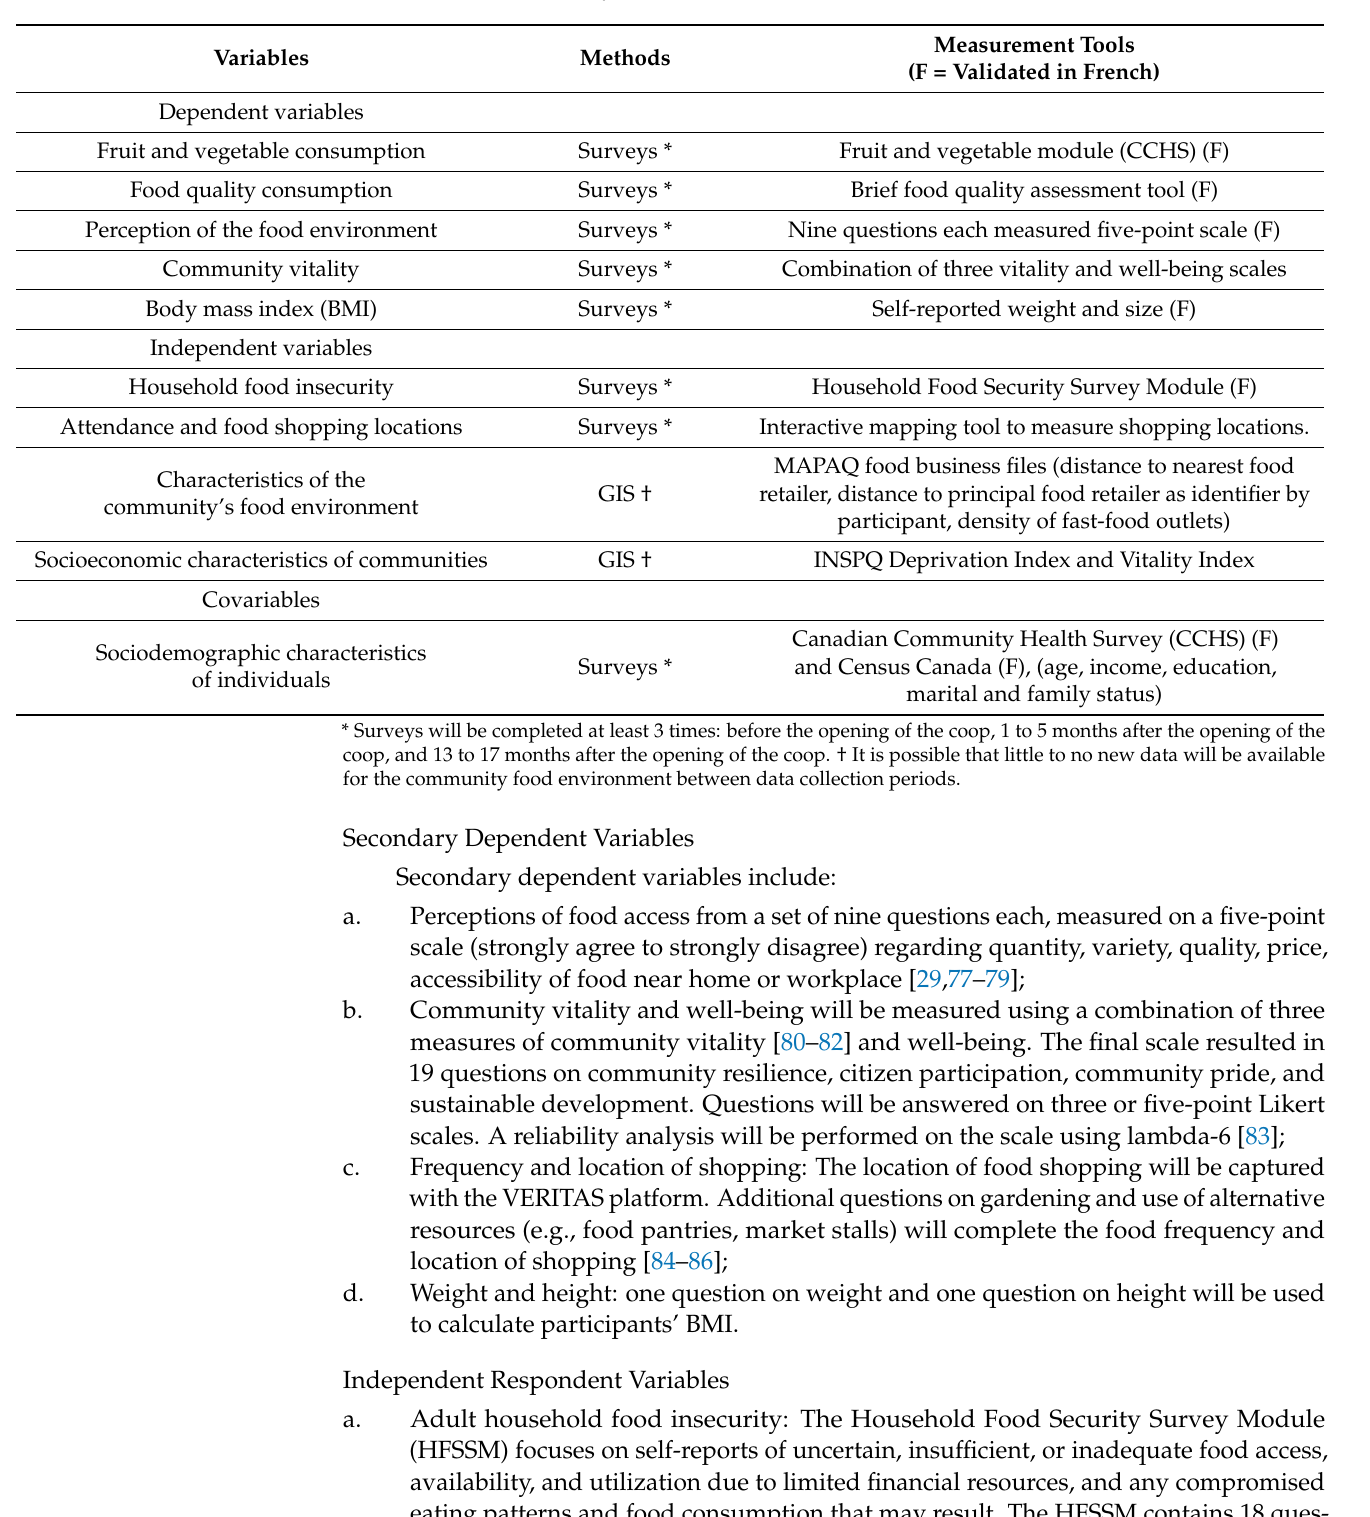
Table 1. Quantitative study